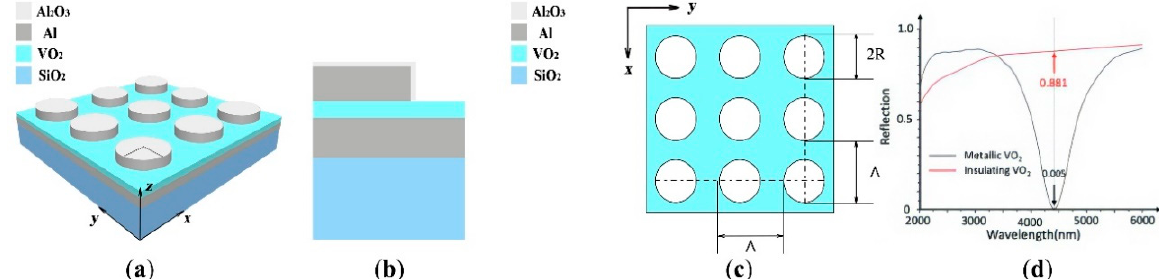
Figure 1. ( a , b ) Structure of the proposed wavelength-selective optical switch. The thicknesses of the VO 2 film, the Al layer, and the SiO 2 film are 50, 180, and 300 nm, respectively. ( c ) Top view of the switch structure. The radius of the Al nano-disk (surrounded by Al 2 O 3 film with a thickness of 3 nm) is R = 300 nm, its height d Al Nanodisk = 220 nm, and the period of the structure Λ = 800 nm. ( d ) Spectral reflectance characteristics of the optical switch for TM polarized light at oblique incidence before and after the VO 2 phase change. Here, the VO 2 phase is changed through a temperature change to adjust the ON and OFF modes of the optical switch.